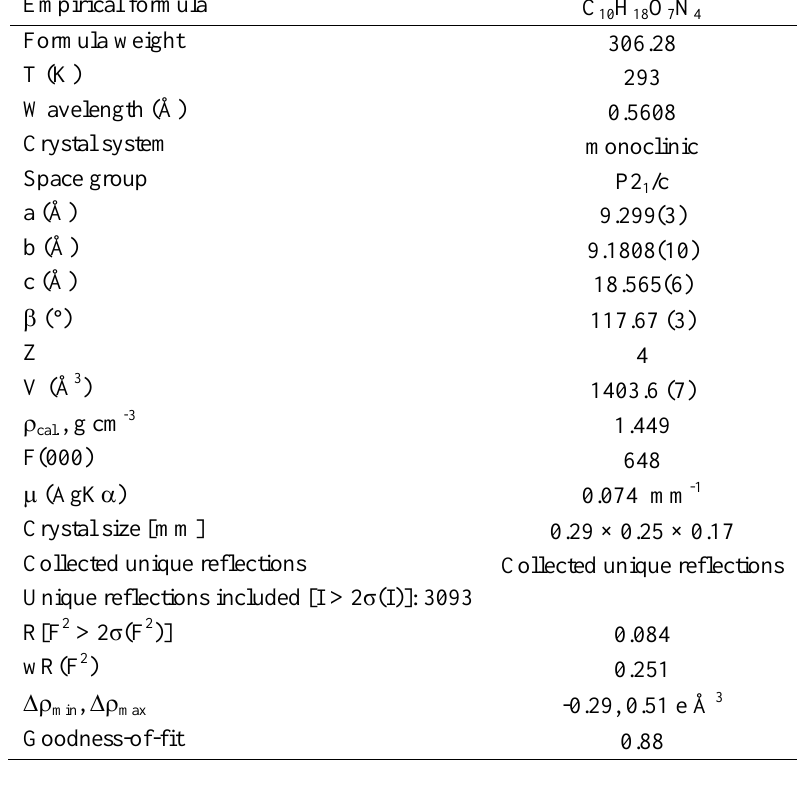
Table 1. Crystal data and experimental parameters used for the intensity measurements.